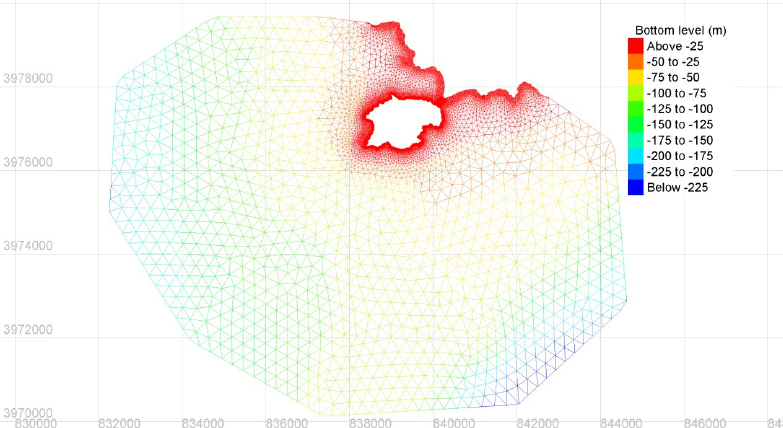
Figure 6. Triangular finite element mesh with bottom level information in the wide area of interest. Mesh created in Blue Kenue™ software tool for hydraulic modellers.